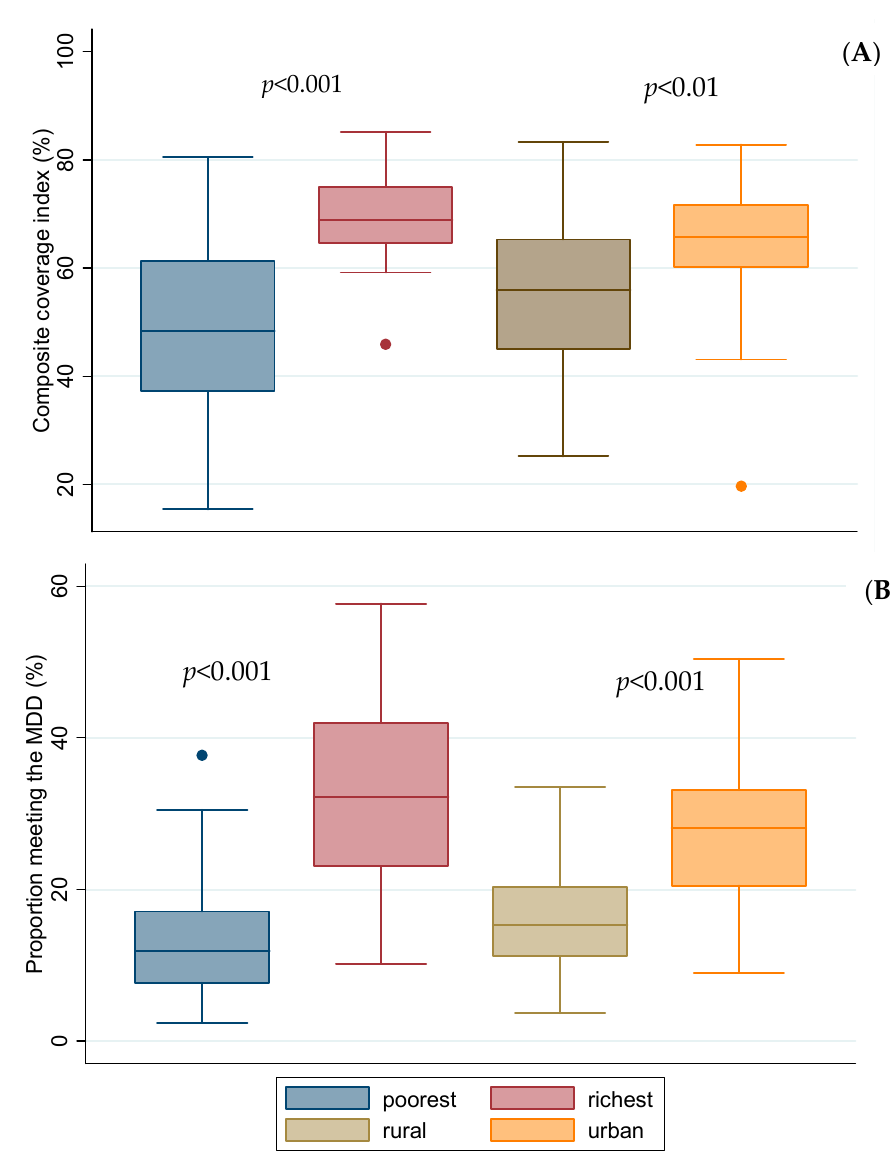
Figure 6. Coverage index of eight reproductive maternal neonatal and child interventions along the continuum of care ( A ) and proportion of children meeting minimum dietary diversity score ( B ) by rural / urban and poorest / richest quintile ( n = 34). The boxplots present country level analyses of the latest round of DHS or MICS. Statistical tests are from independent t -test comparing prevalence in the poorest to the richest quintiles and rural to urban residents.